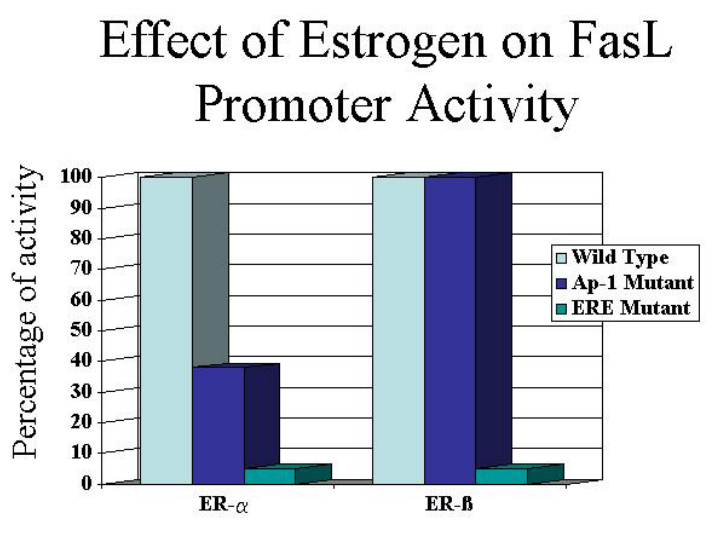
FIGURE 3 . Effect of estrogen on FasL promoter activity. The effect of estrogen on FasL activity was determined using a luciferase reporter gene system. Both ERE and AP-1 motifs are necessary for estrogen-induced FasL activation in ERa bearing cells. On the other hand, only the ERE motif is necessary in ER β bearing